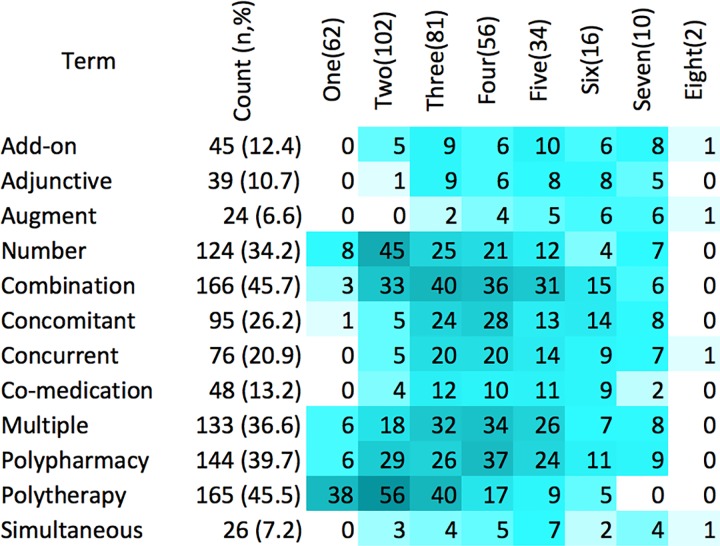
Heat map showing combinations of polypharmacy term.1. The count column shows number (out of 363) and percent of studies that used a specified term. 2. Columns One(62) to Eight(2) specify number of studies with the respective exact number of terms. 3. Cells show number of studies with corresponding term in combination with other terms.